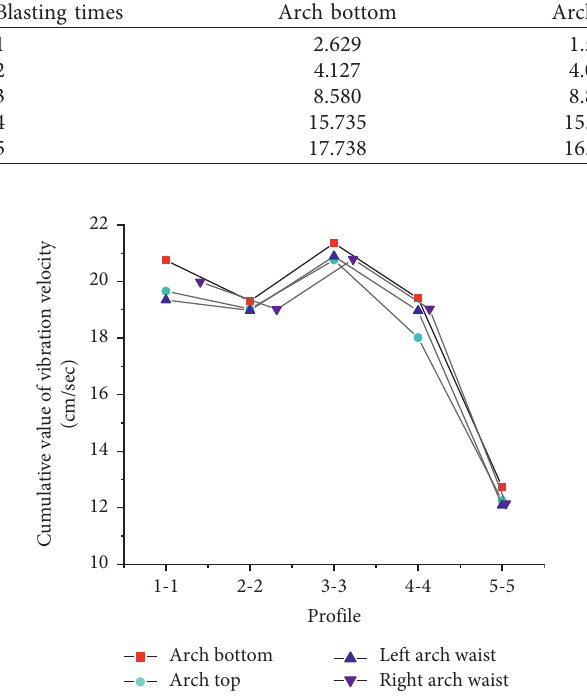
Figure 8: Cumulative value of vibration velocity at different measuring points of each